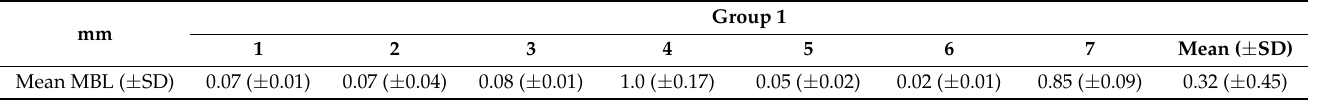
Figure 3. Proinflammatory cytokines IL-6 ( a ), IL-8 ( b ) and TNF- α ( c ), total antioxidant status (TAS)